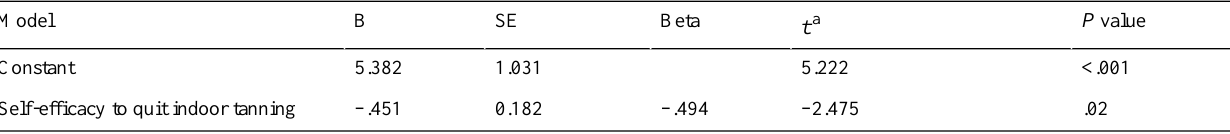
Table 3. Ordinary least squares stepwise linear regression of indoor tanning behavioral intentions on beliefs.